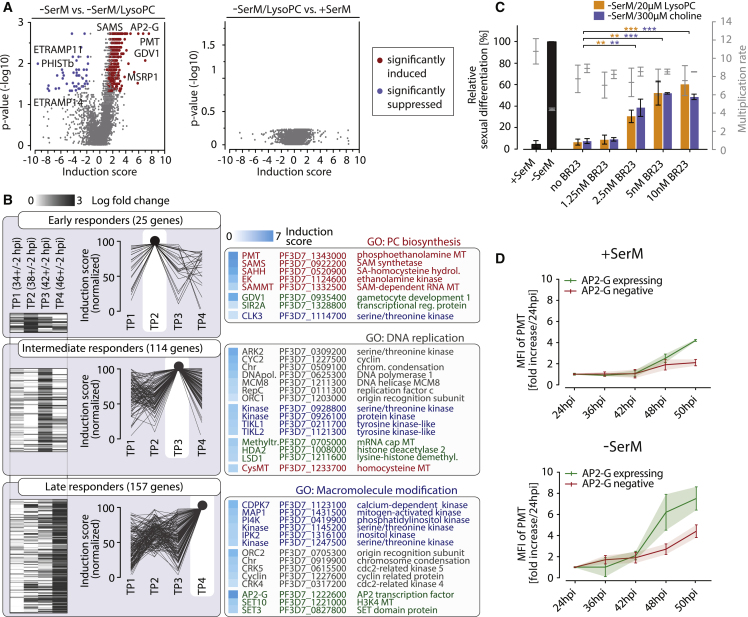
LysoPC Depletion Induces Activity of More Than 300 Genes in P. falciparum(A) Transcriptional responses of two parasite strains (Pf2004/164tdTom and NF54; combined) to absence of LysoPC are shown (left panel). Significantly up- and downregulated genes are highlighted in red and blue, respectively. Data show differential transcription between parasites cultured in −SerM and −SerM/20 μM LysoPC. No significant differential expression could be detected between parasites cultured in +SerM and −SerM/20 μM LysoPC (right panel).(B) Clustering of differentially expressed genes reveals that LysoPC depletion elicits a temporal transcriptional cascade in P. falciparum. Differential induction of genes (−SerM vs. −SerM/LysoPC conditions) per time point is shown in a heat map (left panel) and stacked line graph (middle panel). For each time point, the highest-enriched gene ontology (GO) term (p < 0.05) and a subset of significantly induced genes are shown (right panel). Factors involved in epigenetic regulation and/or differentiation are marked in green.(C) CK inhibitor BR23 (Serrán-Aguilera et al., 2016) reverses activity of LysoPC and excess choline, corroborating importance of the Kennedy pathway in regulating sexual differentiation. n = 3, standard deviations are shown, ∗∗ p < 0.01, ∗∗∗ p < 0.001, Student’s t test.(D) PMT expression is increased in sexually committed schizonts. Enzyme levels were quantified in a time-course experiment. While PMT is generally induced under −SerM conditions, sexually committed cells show a more prominent induction. MFI, mean fluorescence intensity; a minimum of 100 infected red blood cells (iRBCs) were analyzed by confocal microscopy. Measurements were repeated in triplicate experiments. Stadard errors of the means are shown.See also Figures S3 and S4 and Dataset S2.